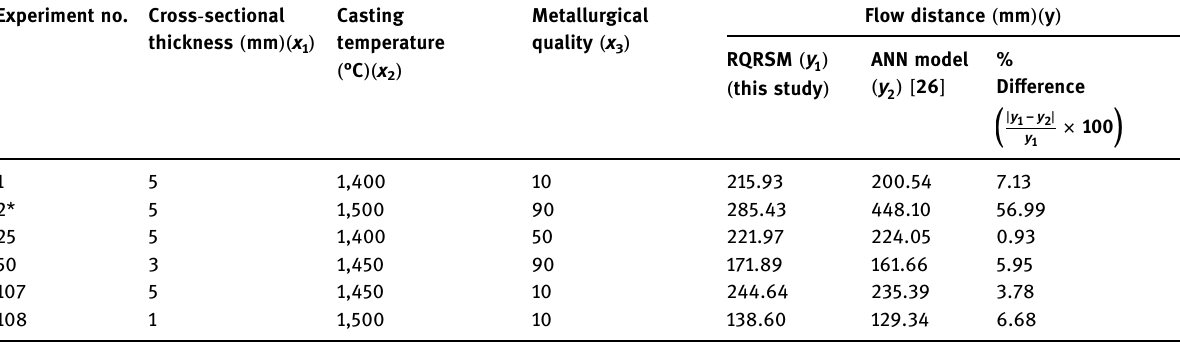
Table 4: Comparison of the results of the present study with the ANN model [ 26 ] Experiment no. Cross -